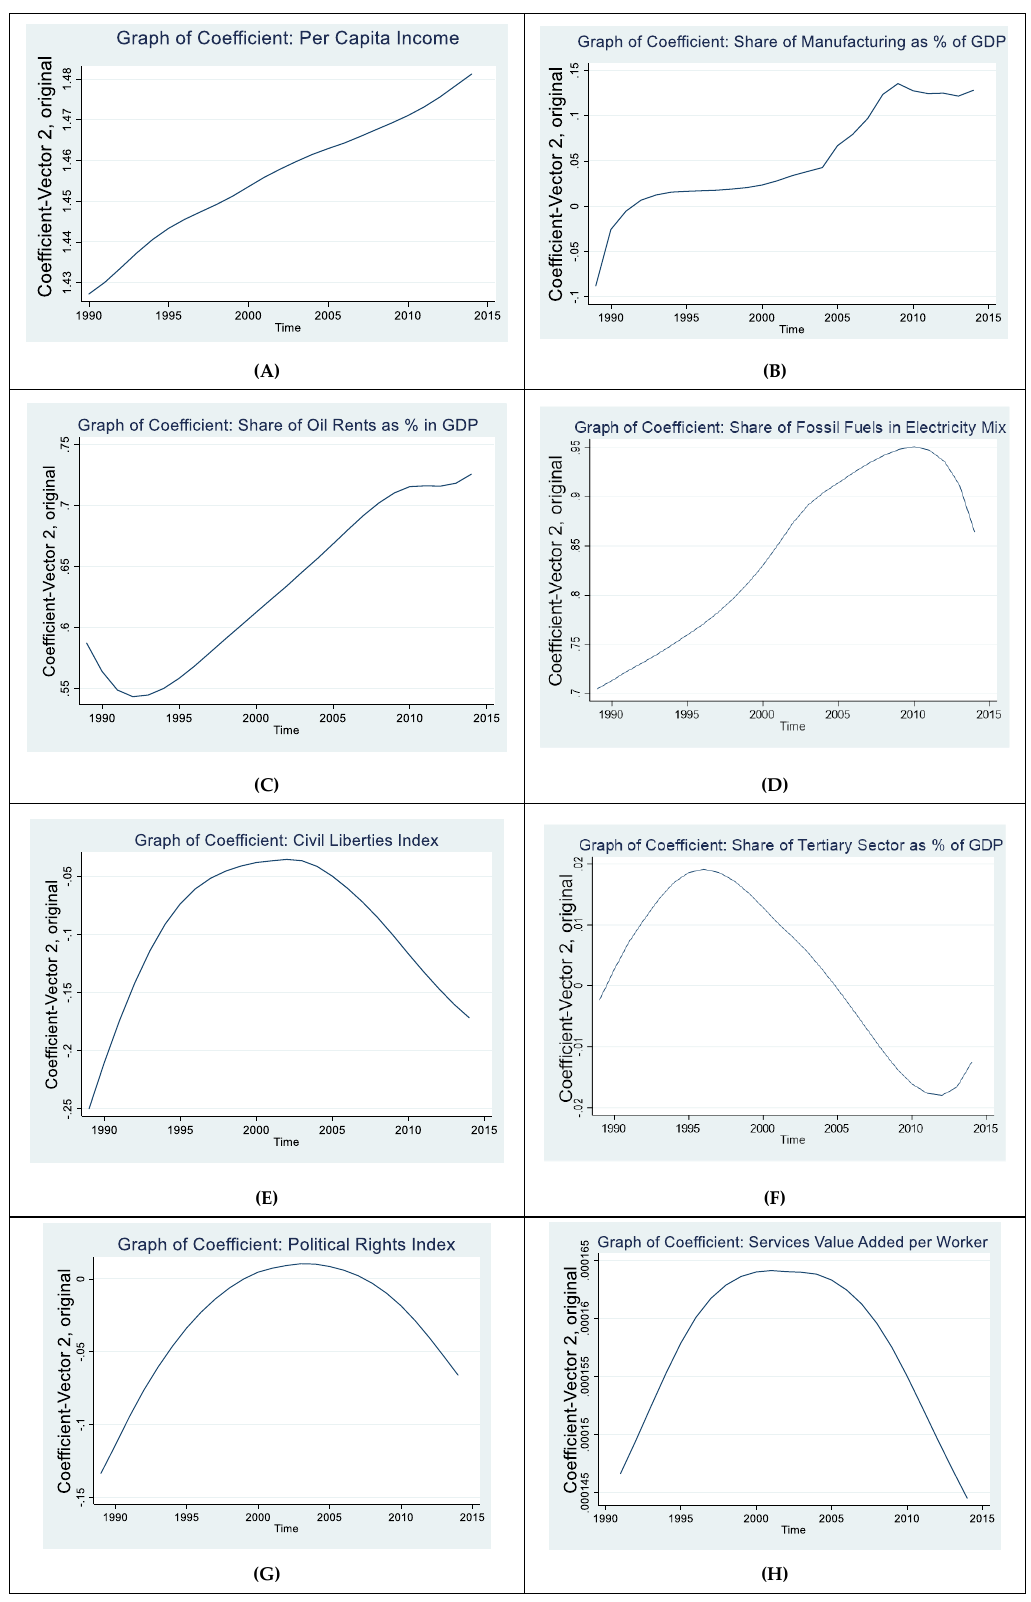
Figure 3. Time-Varying Responsiveness of Per Capita CO 2 Emissions to changes in average Income, composition variables, political freedoms and civil